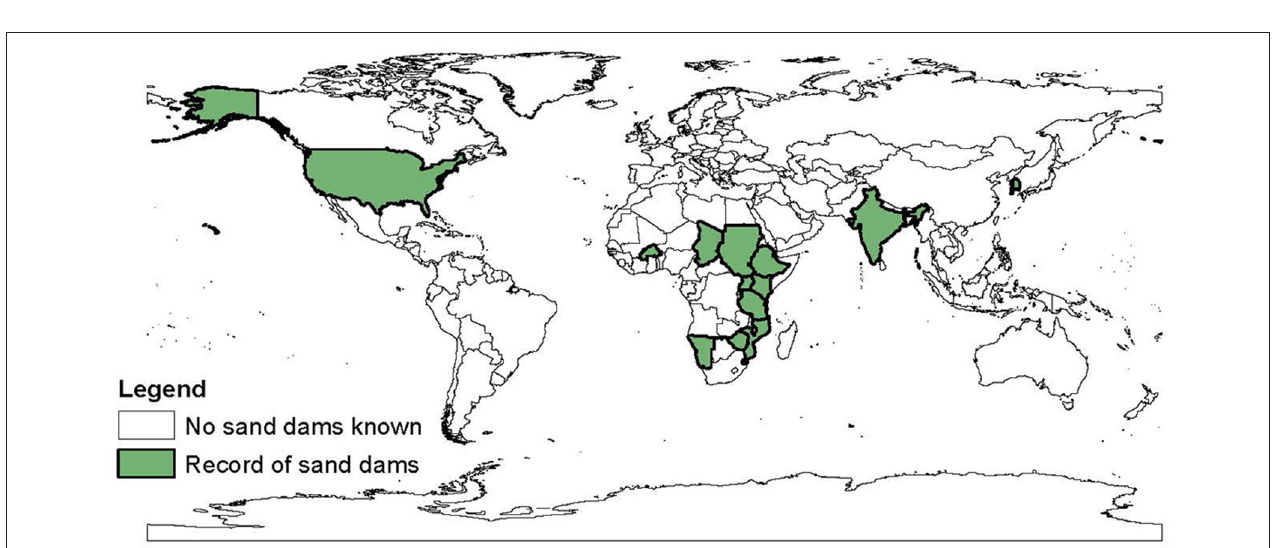
FIGURE 3 | Sand dams have spread to drylands around the world. Countries with known sand dams are